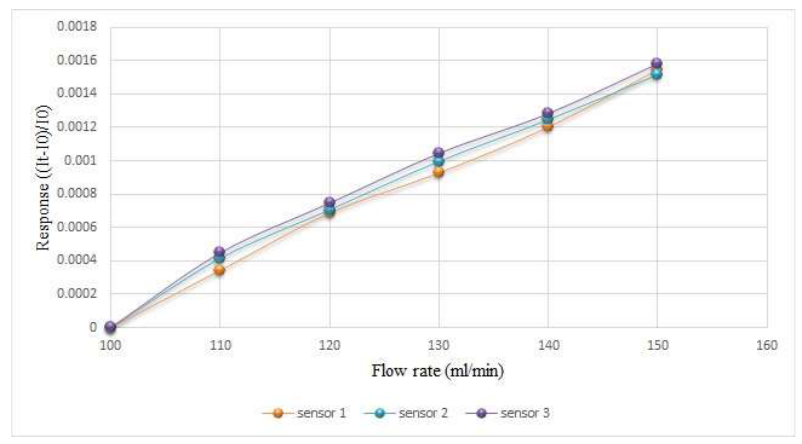
Figure 9. Calibration of micro flow sensor in water-passing state.